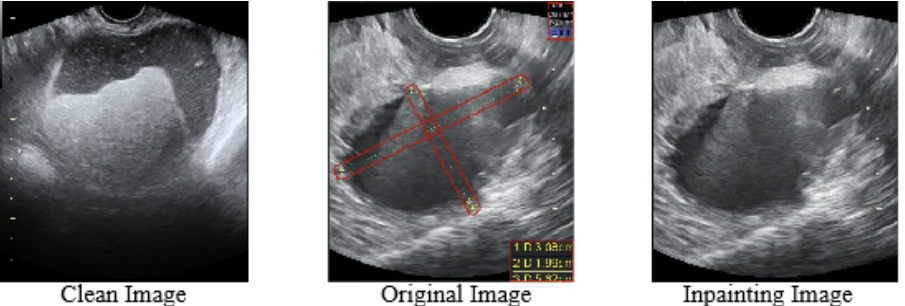
Figure 1. ( Clean Image ) The clean images indicate images that are not clinically labeled. ( Original Image ) The original images indicate clinical images that are labeled. The red-boxed areas show the various marker symbols used by physicians. ( Inpainting Image ) The inpainting images indicate images whose symbols are